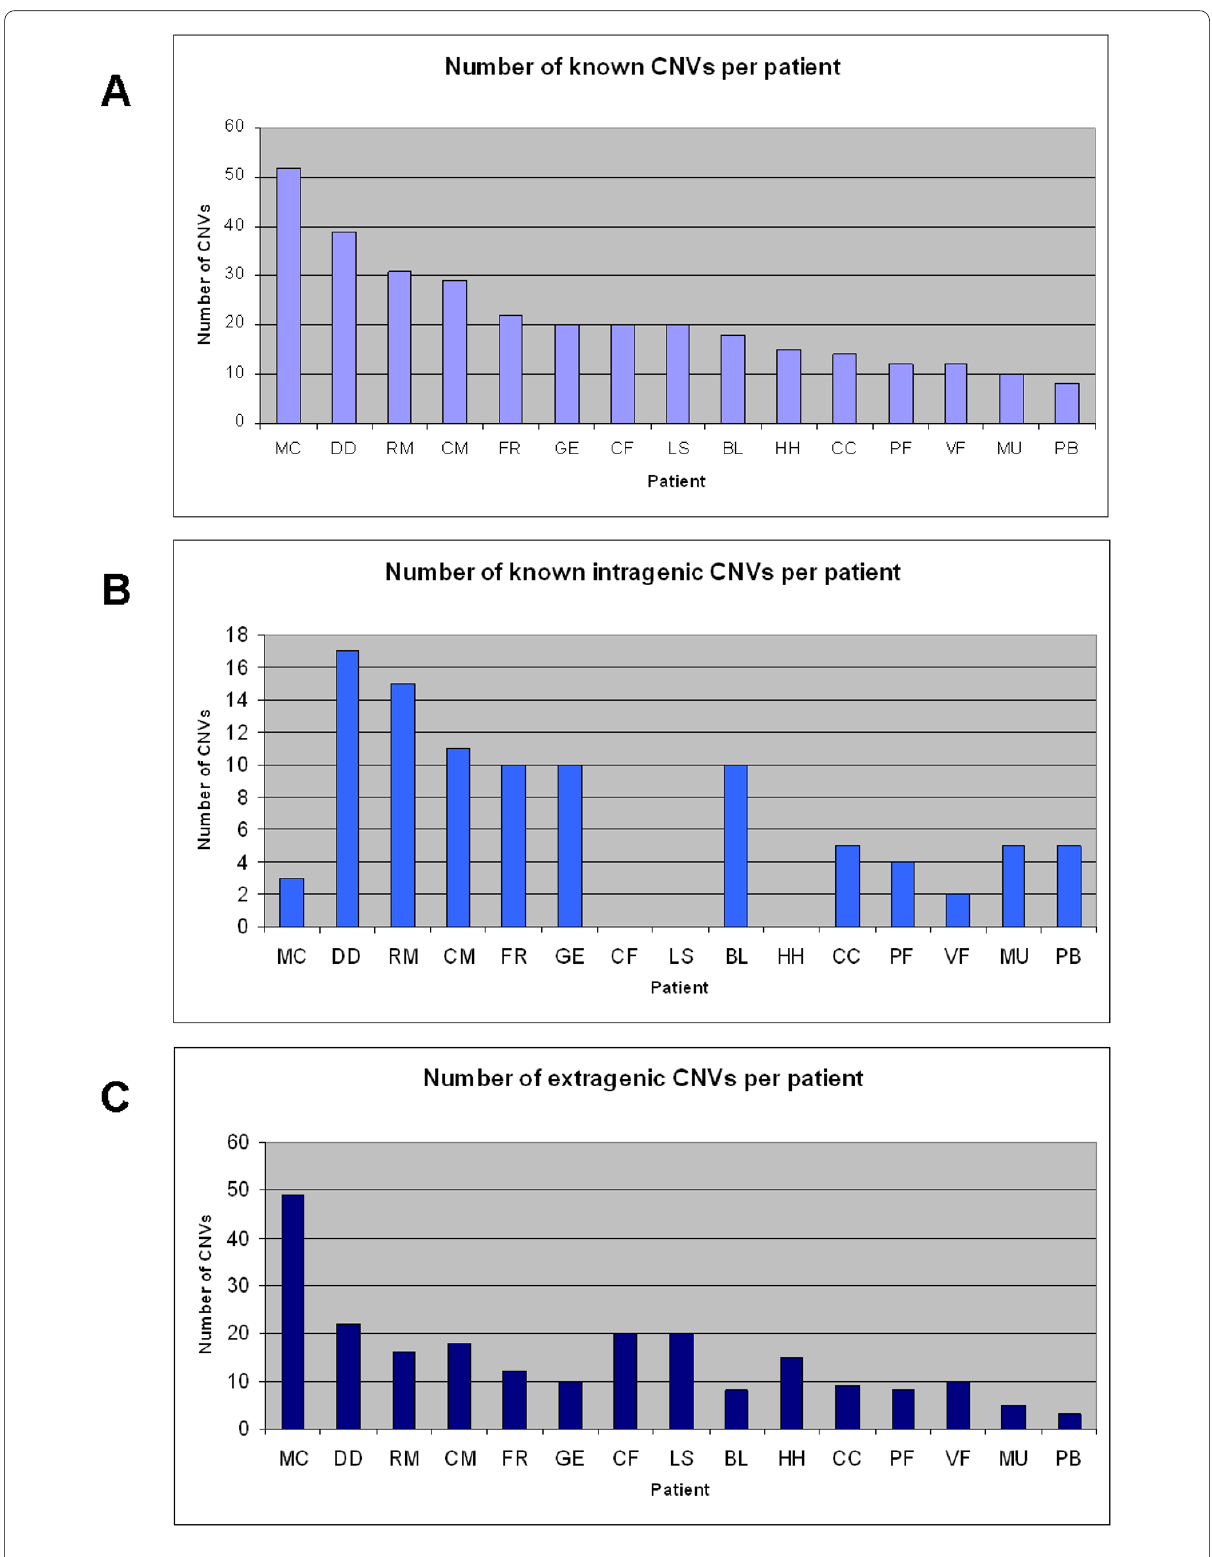
Figure 3 Number of total (A), intragenic (B) and extragenic (C) known CNVs reported in the Database of Genomic Variants ( http://projects.tcag.ca/ variation) per patient